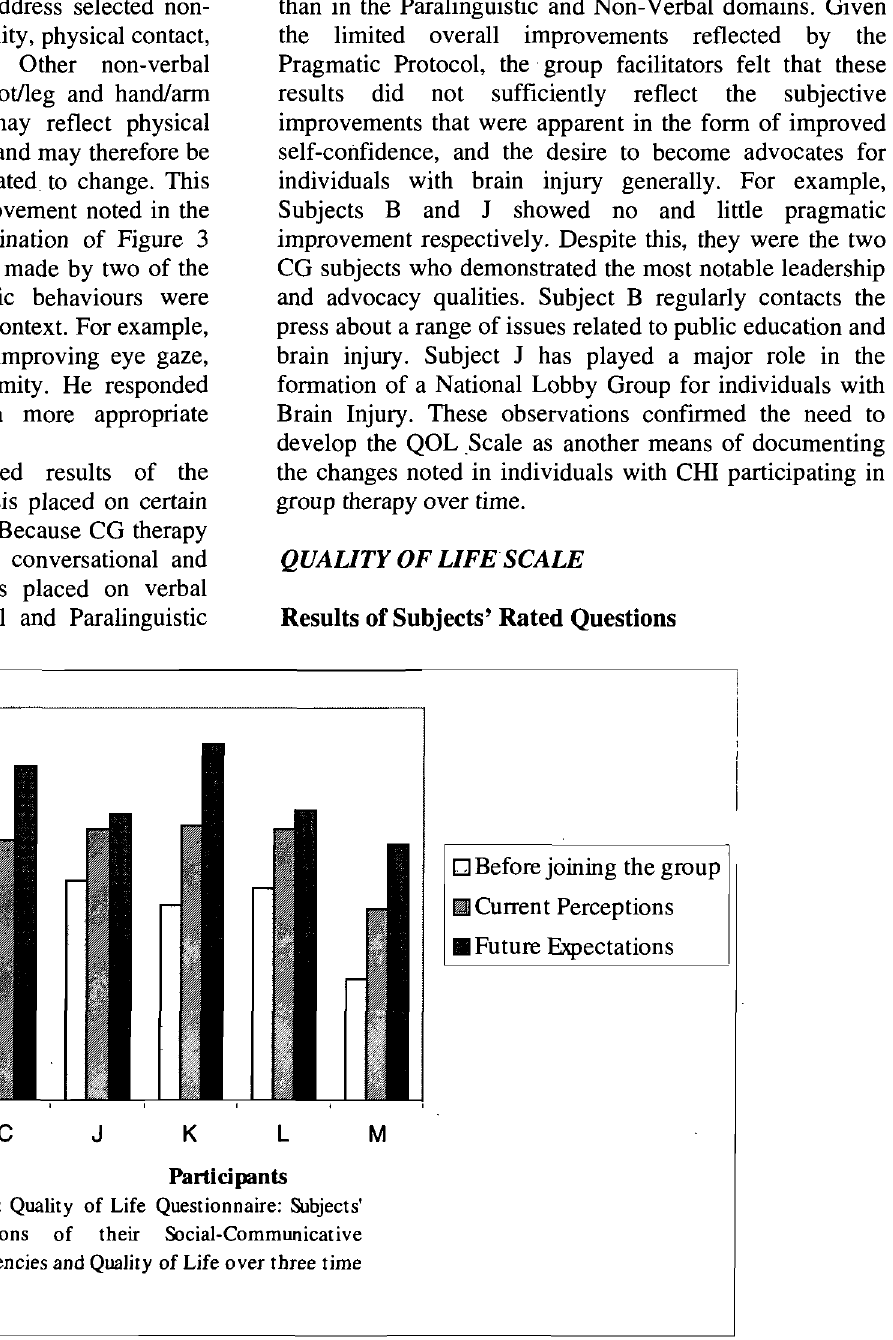
Figure 4: Quality of Life Questionnaire: Subjects' Perceptions of their Social-Communicative Competencies and Quality of Life over three time